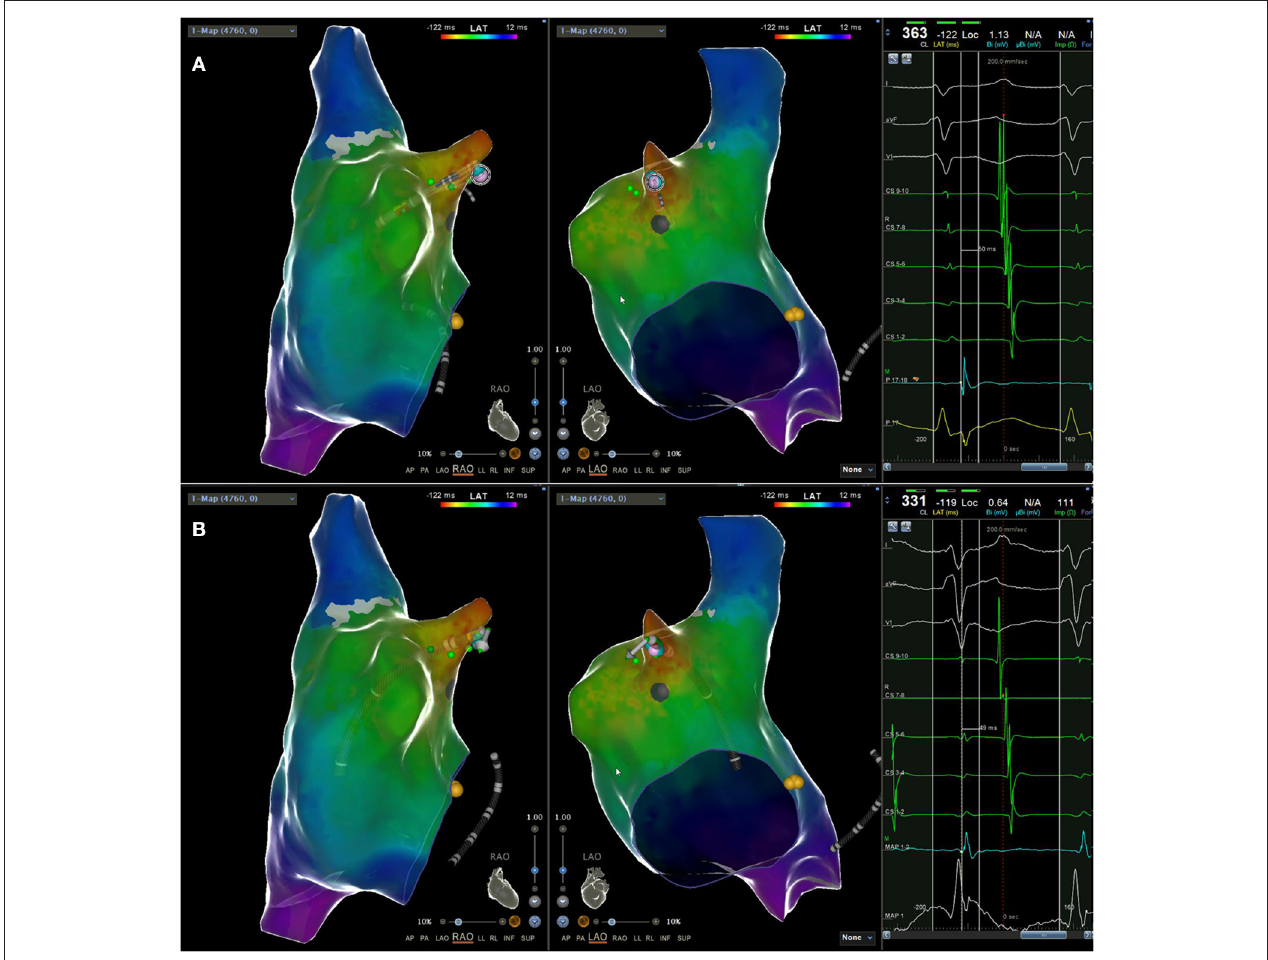
FIGURE 2 | The earliest activation point (located at the apex of the right atrial appendage) measured by (A) the Pentaray electrode 50ms ahead of the body surface P wave; (B) the ST ablation catheter 49ms ahead of the body surface P